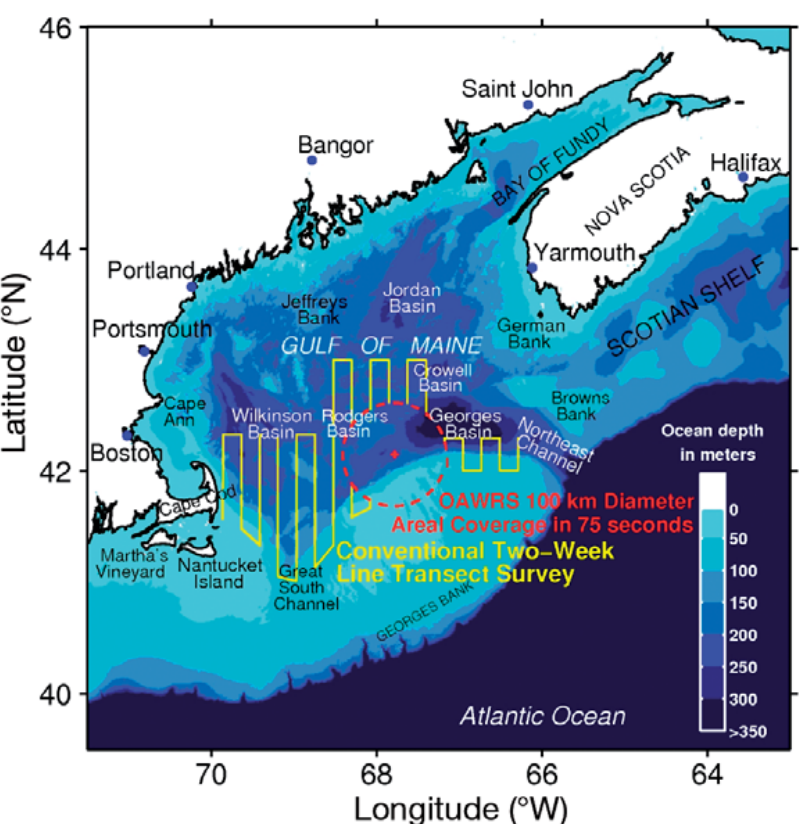
Figure 1. Instantaneous areal coverage of a single OAWRS transmission in the Gulf of Maine 2006 experiment shown over bathymetry. A region of 100 km in diameter (red circle) and roughly 8000 square kilometers is surveyed within 75 s by OAWRS. Widely spaced line transects of the concurrent National Marine Fisheries Service (NMFS) two-week survey. NMFS used a downward directed echo-sounder to sense within a few horizontal meters of the research vessel track shown in yellow. Yellow NMFS survey tracks are not shown within the OAWRS circle to avoid visual clutter, but extended there along the lines shown.